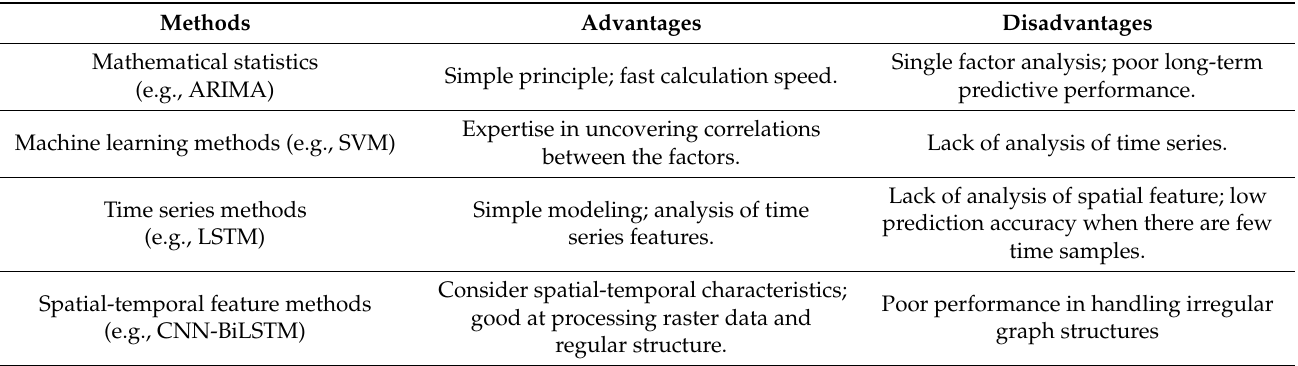
Table 1. Comparison of temperature prediction